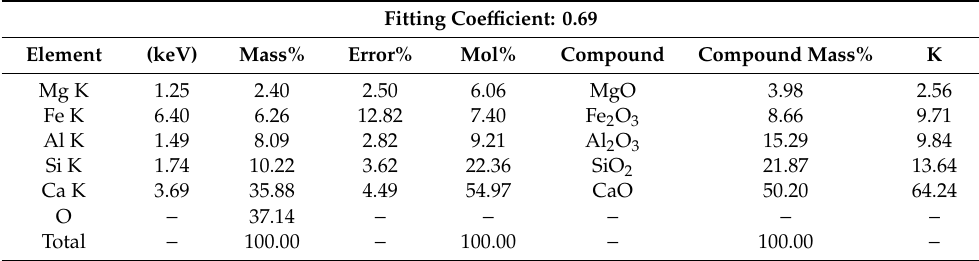
Table 6. Identified elements in Ofunato Ca(OH) 2 (black particles) after a 1st hydration in the TGA-51 system and decarbonization in a mu ffl e furnace (measured by Energy Dispersive X-ray Spectroscopy). Fitting Coe ffi cient: 0.69